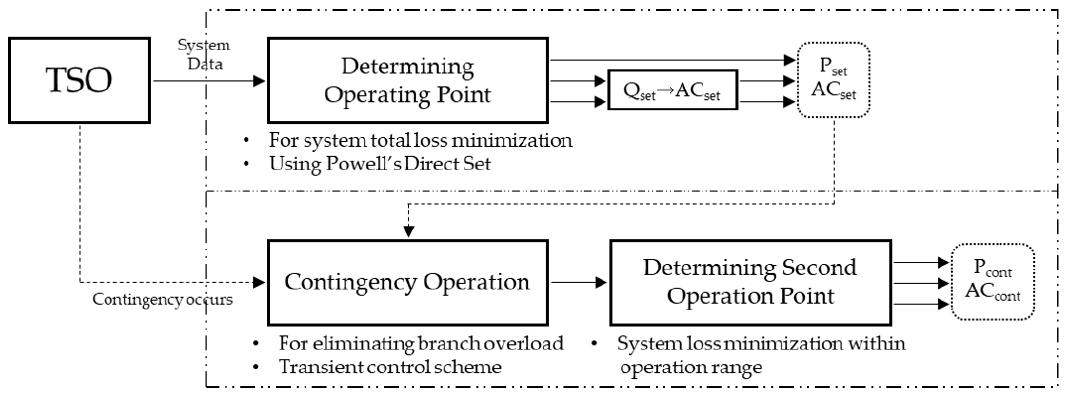
Figure 2. Proposed control scheme.